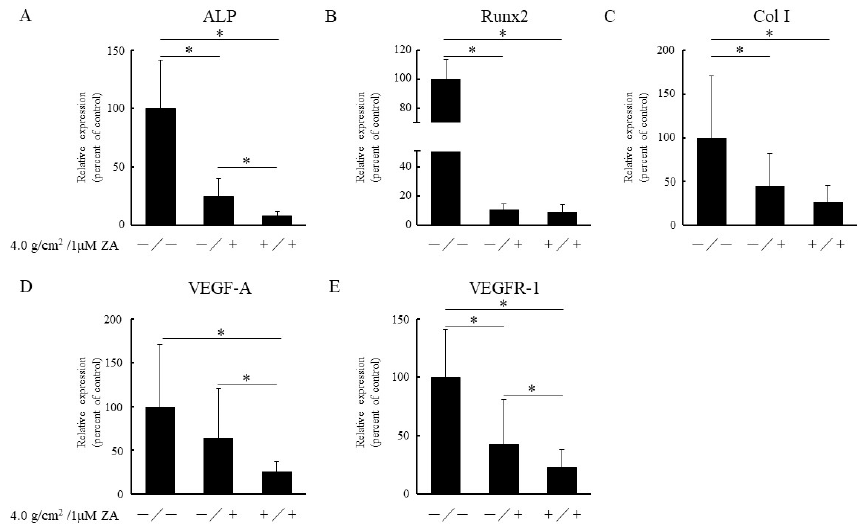
Figure 3. Quantification of expressions of osteoblast-related genes ( A : ALP; B : Runx2; C : Col I; D : VEGF-A; and E : VEGFR-1) using real-time PCR. Results are expressed as mean ± SD. * p < 0.05.